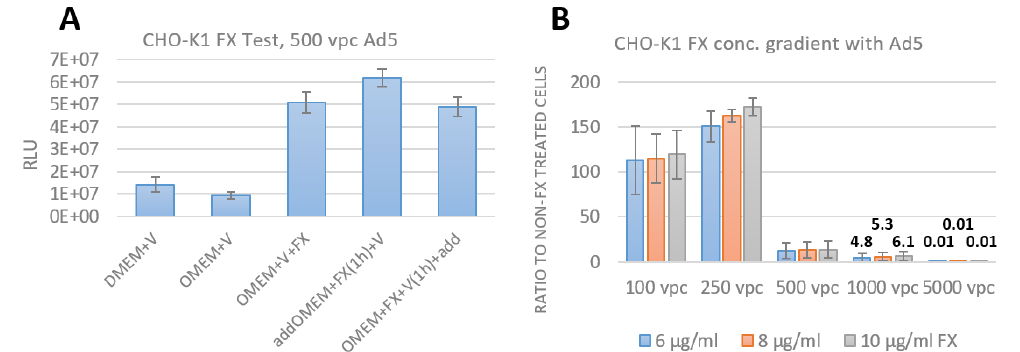
Figure 4. Establishment of the experimental setup for FX experiments in CHO-K1 cells. ( A ). Infection of CHO-K1 cells with 500 vpc of Ad5 and 10 µg/mL FX. As controls, virus only in DMEM and OMEM was used. As a first condition, FX and virus were added simultaneously to the cells; as the second condition, FX was preincubated for 1 h with the cells and then virus was added; as a third condition, FX and virus was preincubated for 1 h and then added to the cells. Luciferase assays were performed 24 hpi and the data are displayed in relative light units (RLU). n=2 biological replicates. ( B ). Infection of CHO-K1 cells with different vpc of Ad5 and the physiological level of FX in blood from 6 (blue), 8 (orange) to 10 µg/mL (gray). The use of 100 vpc of Ad5 with all used FX concentrations increased the transduction up to 100-fold compared to non-FX treated cells; 250 vpc up to 160-fold. Starting at 500 vpc, the increase was less pronounced (20-fold). However, at this dose, cytotoxic effects from the added virus was observed. The data are displayed as a ratio to non-FX treated cells. Mean ± SEM of n = 3 biological replicates is